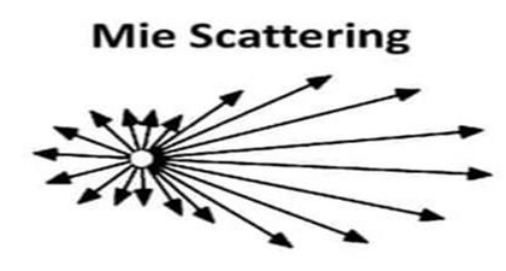
Figure 1: Shapes of Mie scattering according to particle size [13].